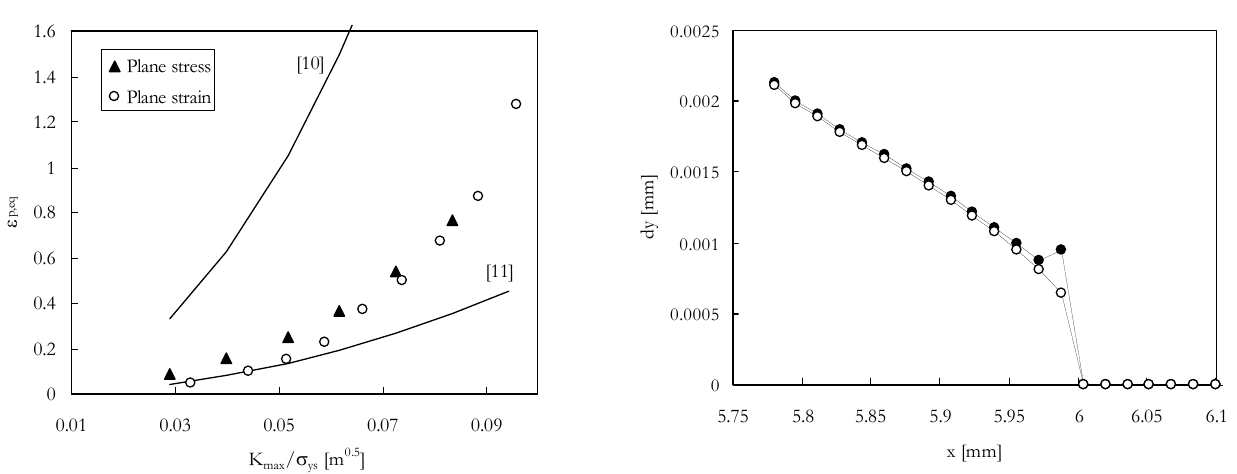
Figure 7: Size of plastic zone perpendicularly to crack flank. Figure 8: Effect of load cycles without propagation on crack profile (pure kinematic hardening, plane stress, L 1 =16 